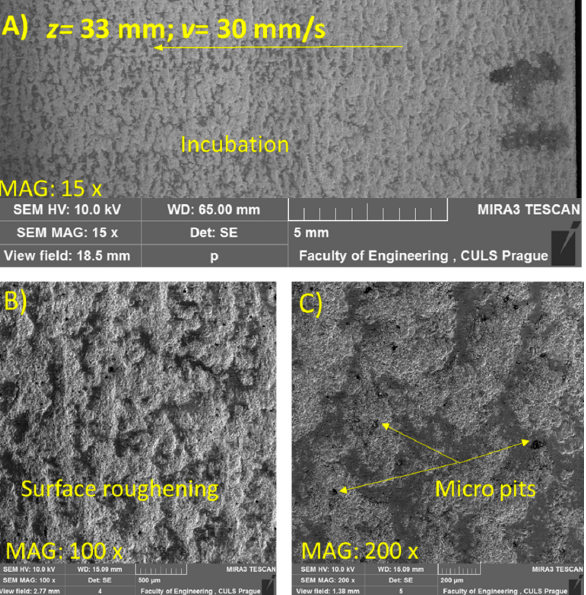
Figure 6. SEM image of sample subjected to p = 70 MPa, z = 33 mm, and v = 30 mm/s (A) at magni ‐ fication 15×, (B) At magnification 100× and (C) At magnification 200×. magnification 15 × , ( B ) At magnification 100 × and ( C ) At magnification 200 ×